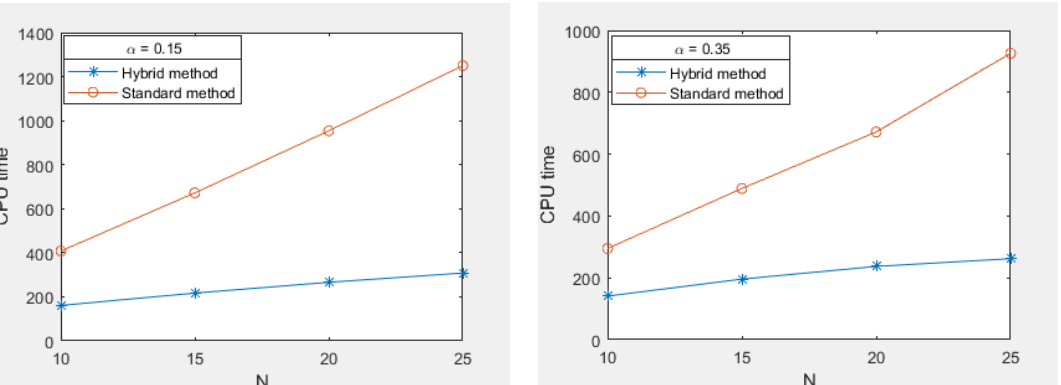
Figure 1. CPU time versus total number of time levels 𝑁 of Example